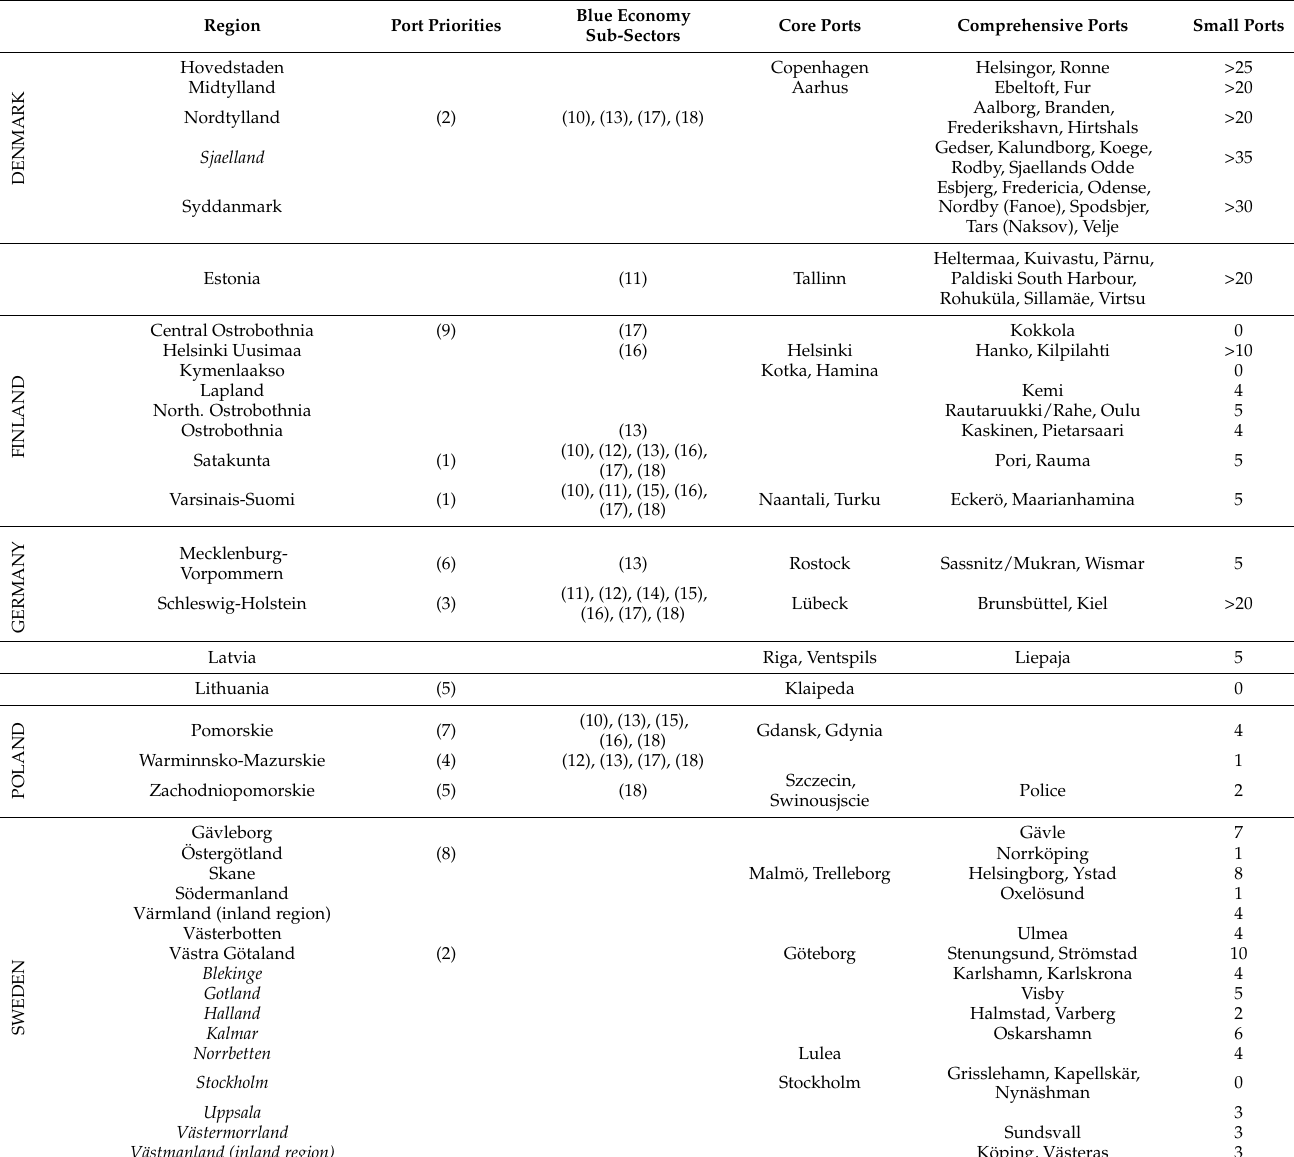
Table 2. RIS3 priority and port presence analysis in 37 Baltic NUTS-2 regions.